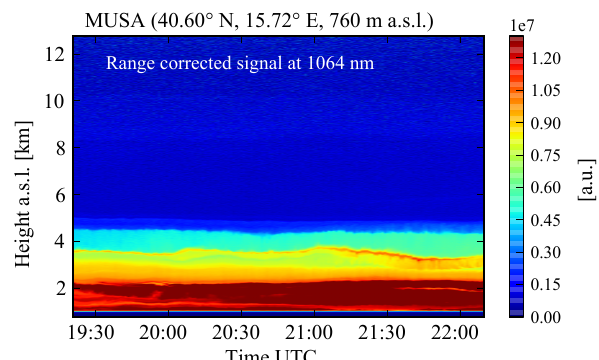
Figure 1. Temporal evolution of the 1064nm range-corrected lidar signal obtained with the MUSA system in Potenza on 14 July 2011,